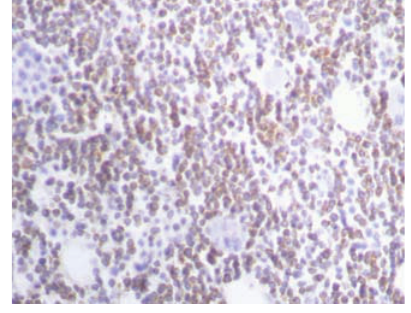
Figure 1. Bcl-2 positivity in a case of follic- ular lymphoma (A): x40.